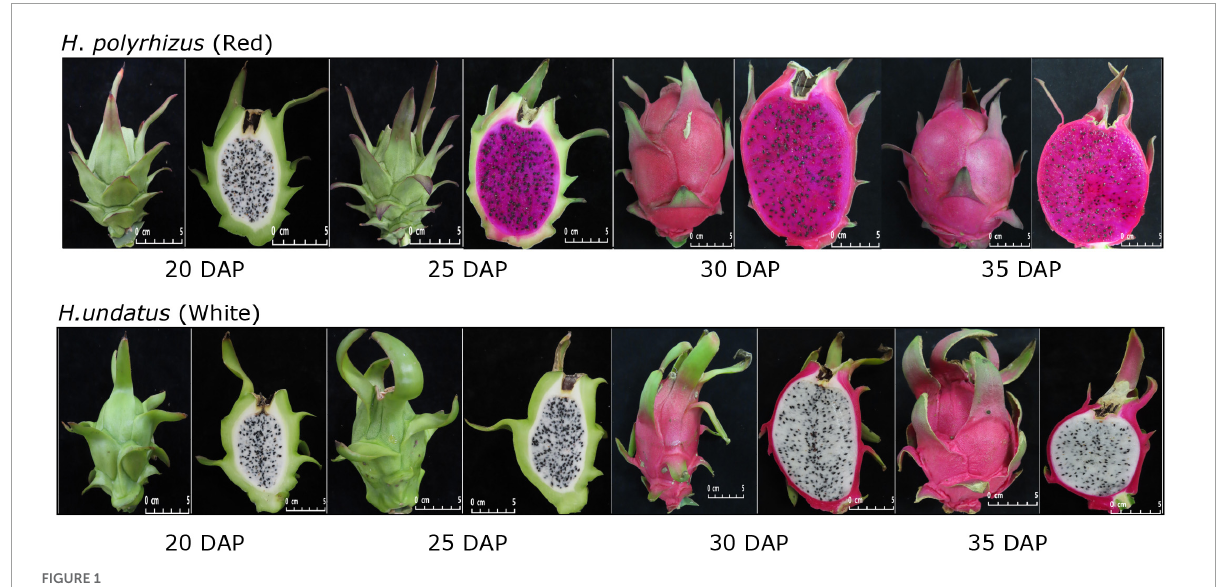
FIGURE1 Different developmental stages of white and red